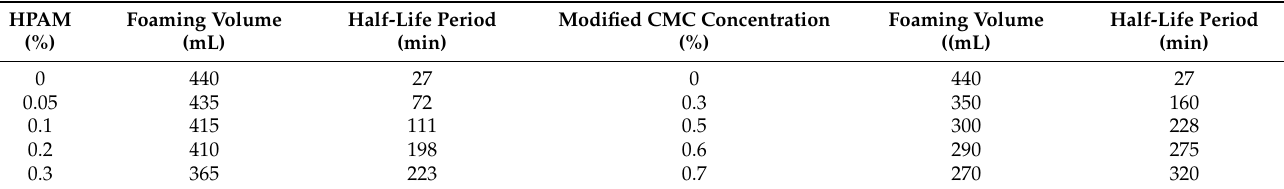
Table 5. Effect of foam stabilizer concentration on foam